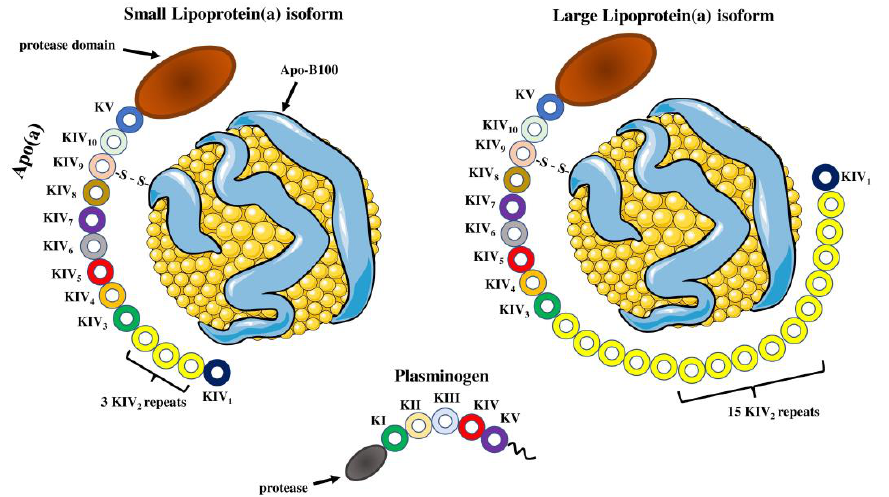
Figure 1. Structure of lipoprotein(a) and plasminogen. Human Lp(a) consists of an LDL-like particle and an apoB-100 particle, in which glycoprotein apo(a) is disulfide-linked. Apo(a) contains 10 dif- ferent types of plasminogen-like kringle IV domains (KIVs), composed of 1 copy of KIV1, multiple copies of KIV2 and 1 copy of KIV3-10 as well as a single kringle V domain followed by an inactive protease domain. KIV2 repeats of apo(a) determine the size of different Lp(a) isoforms. Apo(a) and plasminogen share high amino acid sequence similarity, including the protease domain and kringles type IV and type V. Parts of the figure were drawn by using pictures from Servier Medical Art. Servier Medical Art by Servier is licensed under a Creative Commons Attribution 3.0 Unported License (https://creativecommons.org/licenses/by/3.0/) (accessed on 4 November 2022).